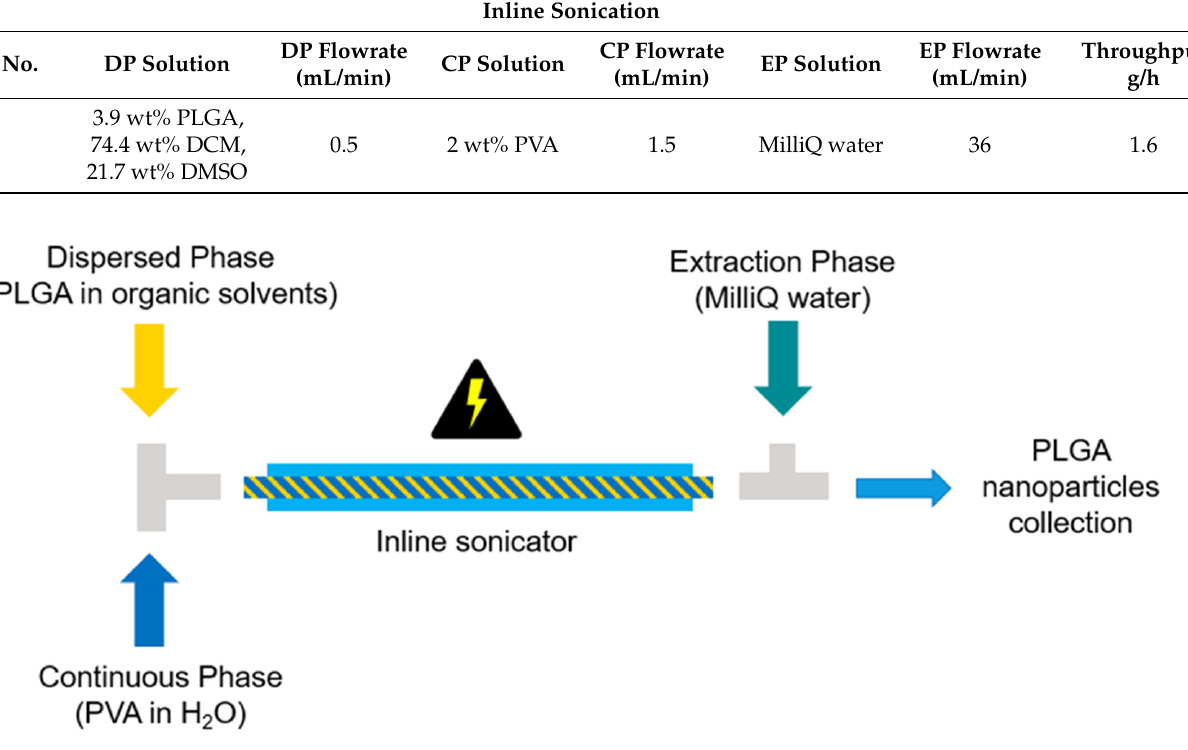
Figure 1. Scheme of the indirect inline sonication process setup for the manufacturing of PLGA nanoparticles. PLGA: poly(lactic-co-glycolic acid); PVA: polyvinyl alcohol.